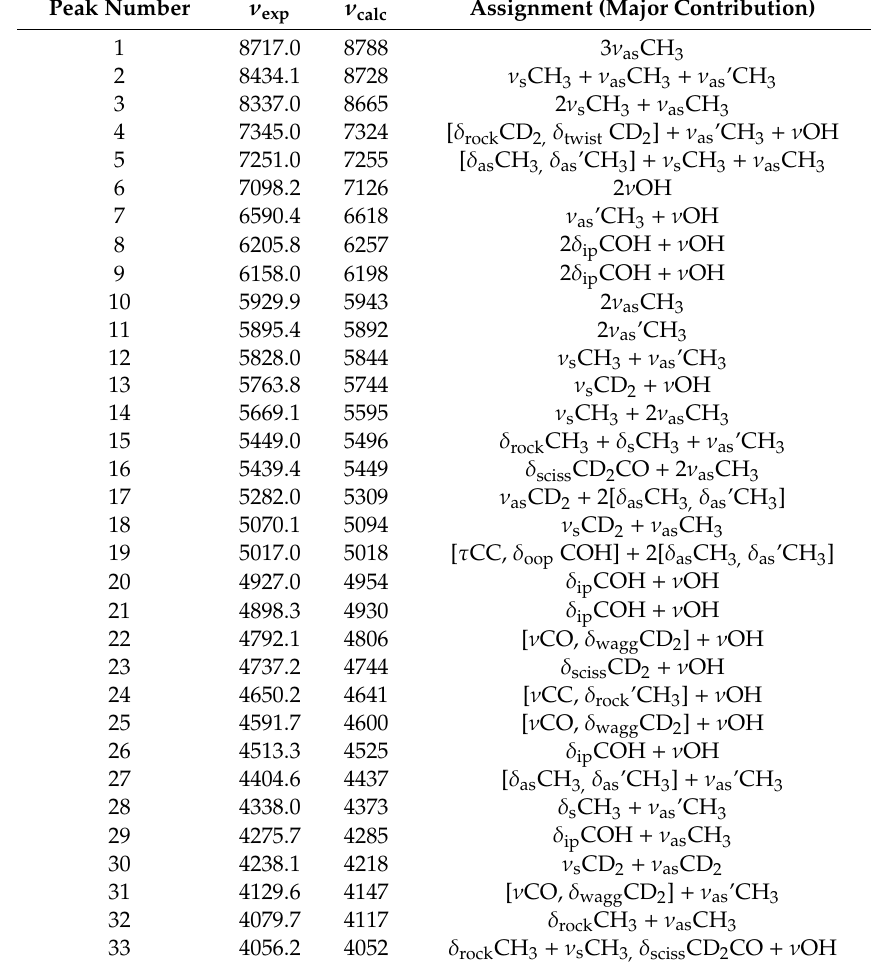
Table 4. Band assignments in NIR spectra of CH 3 CD 2 OH based on GVPT2 // B2PLYP-GD3BJ / def2-TZVP // CPCM calculations. Band numbering corresponds to that presented in Figure 5C.